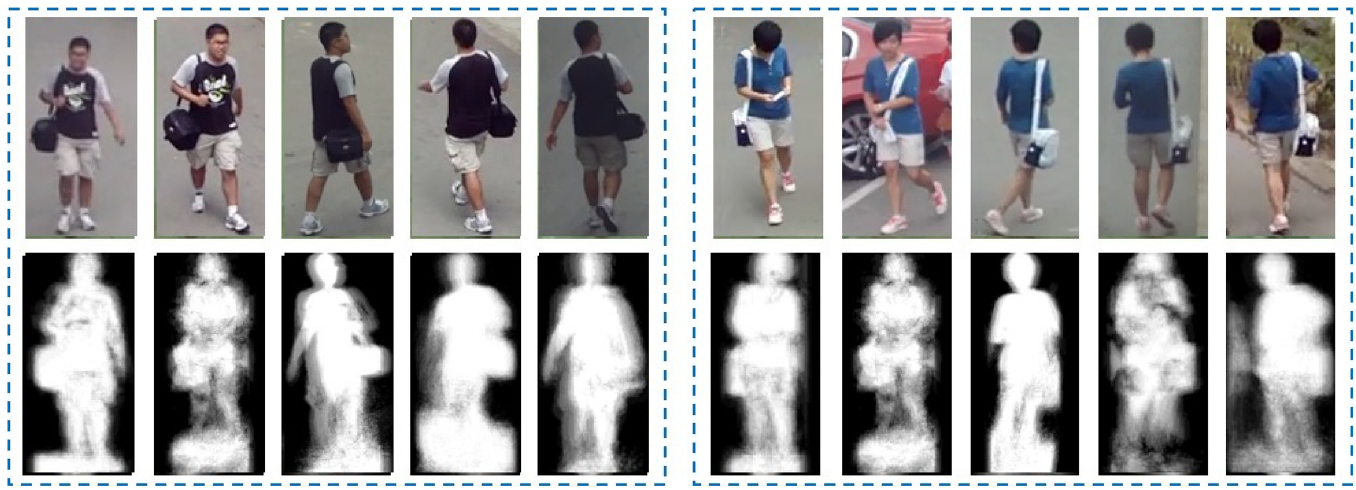
Fig 1. Within free-view scenes with weak control and definition, both probe and gallery gait sequences could be captured from arbitrary views. For example, as shown in this figure, the two groups of samples from the PKU HumanID Gait Dataset [12] has low-quality gait features.